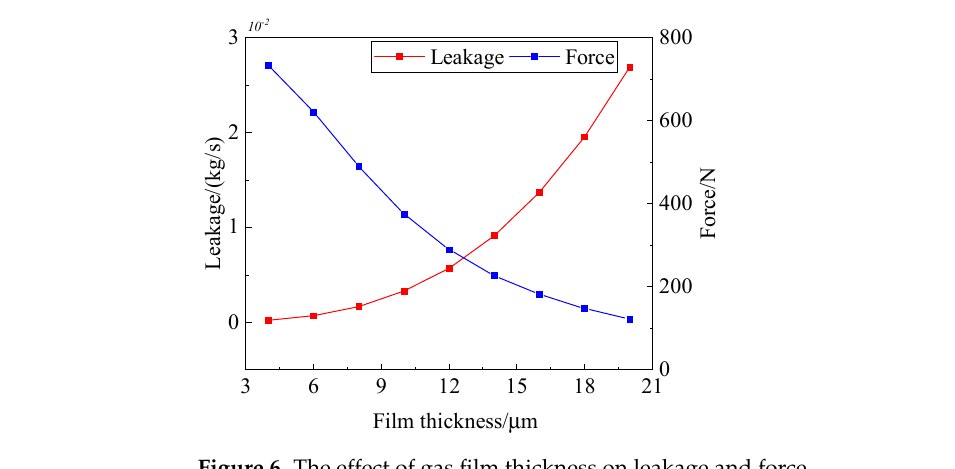
Figure 6. The effect of gas film thickness on leakage and force.